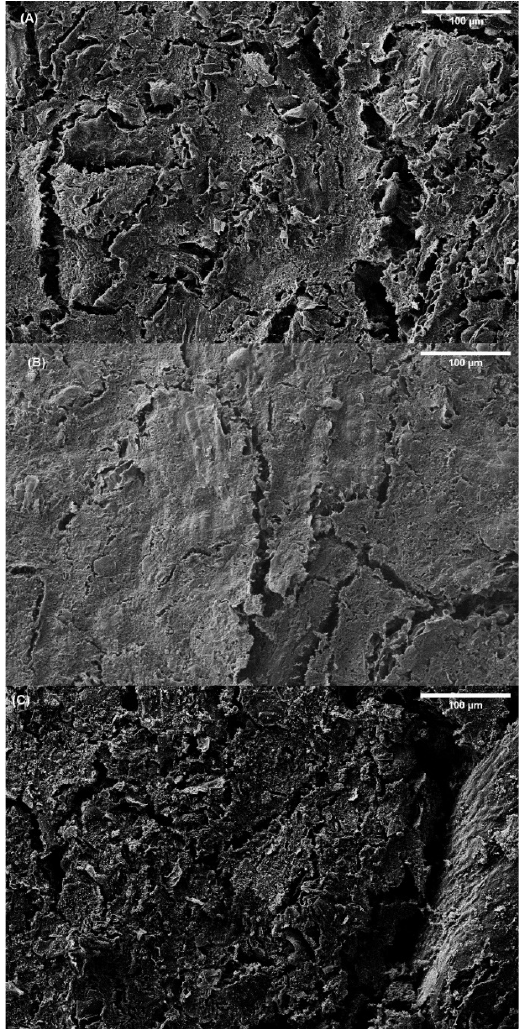
Figure 11. Scanning electron spectroscopy images of RO/GLY 70/30 bioplastics molded at 90 °C ( A ), 120 °C ( B ) and 150 °C ( C ) with a magnification of 200×. 120 ◦ C ( B ) and 150 ◦ C ( C ) with a magnification of 200 ×